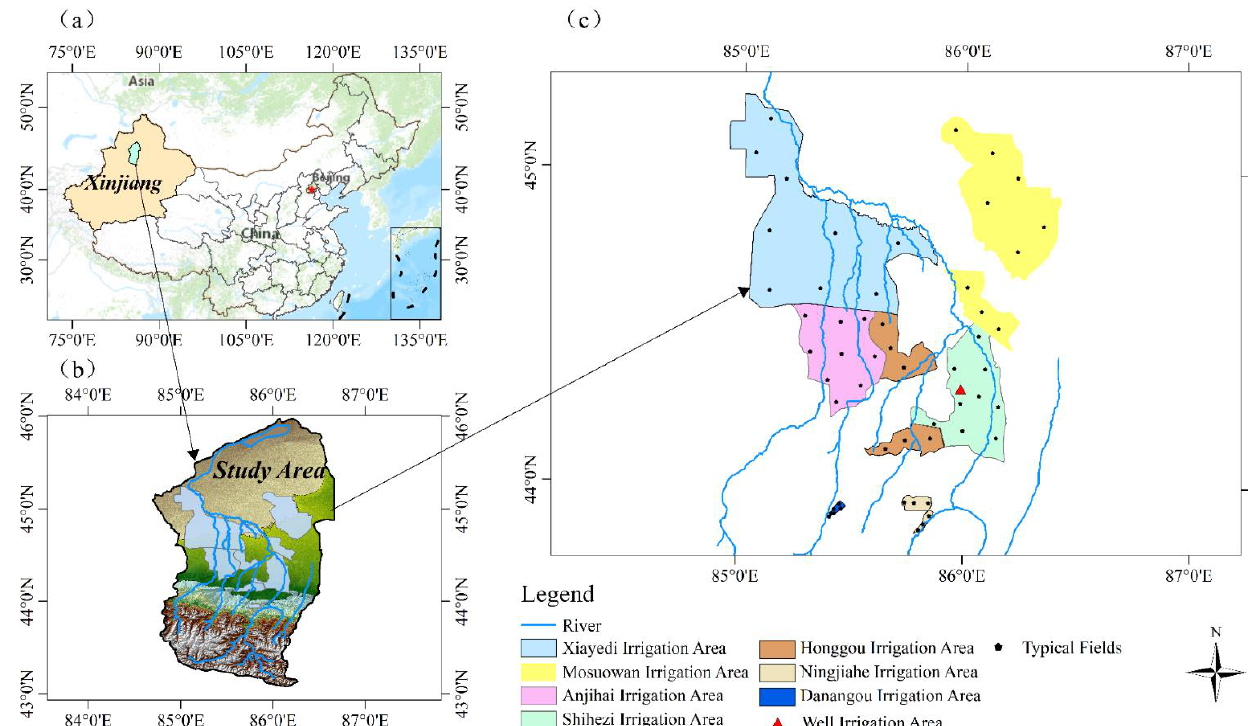
Figure 1. The study area is an oasis agroecosystem in the Manas River Basin ( b ) in Xinjiang, located in the northwest of China ( a ), and includes 8 irrigation areas. All typical field locations are shown in ( c ).